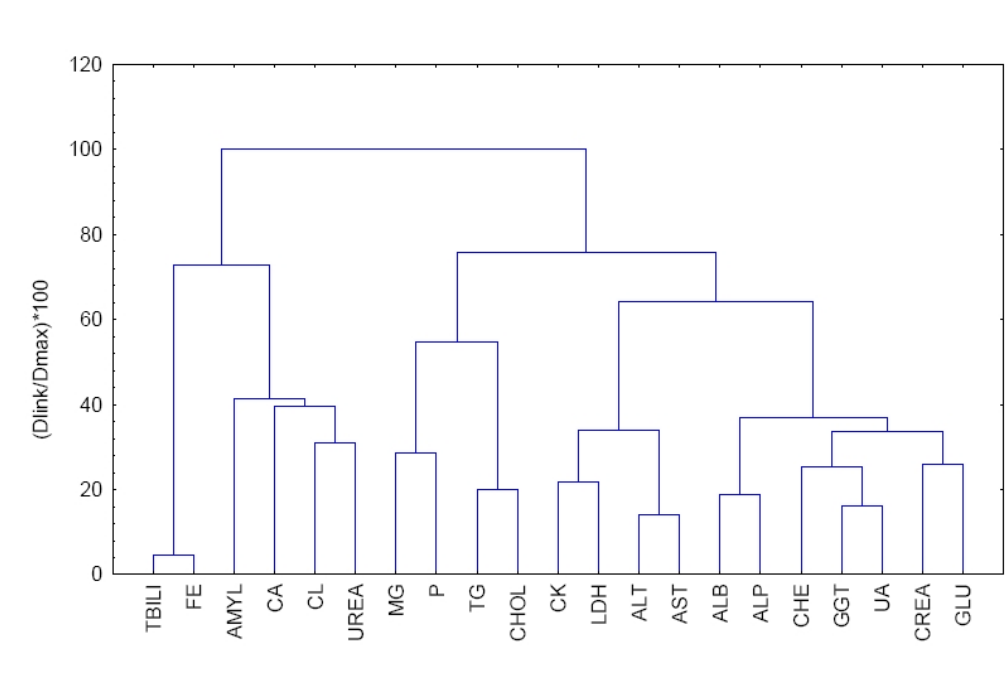
Fig. 5 Hierarchical dendrogram for 21 clinical parameters of “adult” healthy